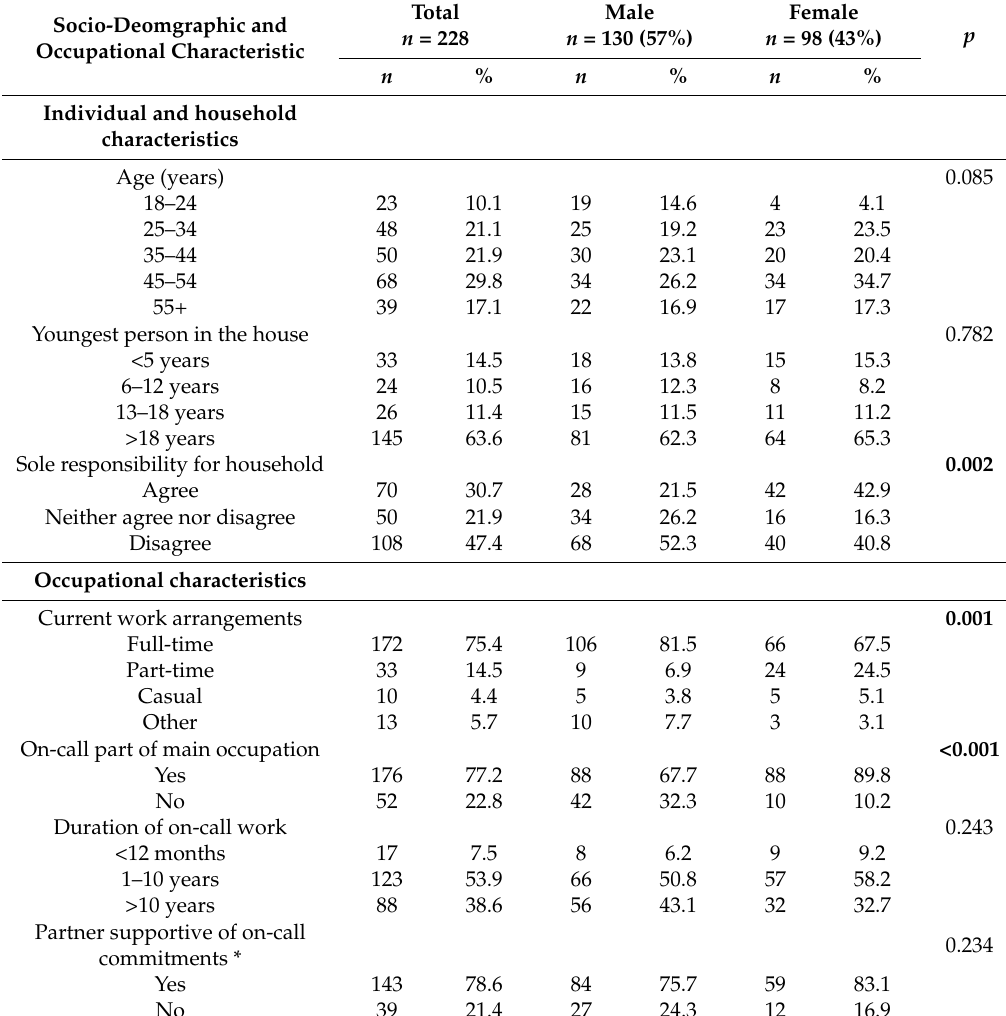
Table 1. Socio-demographic and occupational characteristics of respondents, highlighting statistically significant differences between male and female respondents for each